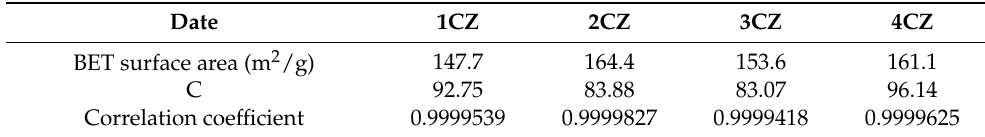
Figure 7. BET surface area plot for the CZ nanoparticles. Table 3. BET data for the CZ nanoparticles.